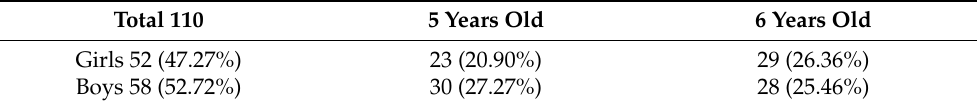
Table 1. One hundred and ten eligible children group division according to gender and age. Total